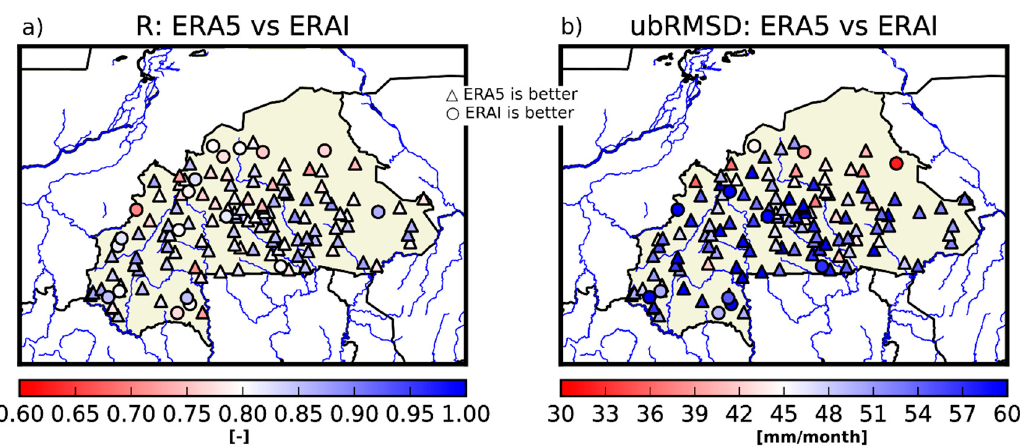
Figure 3. Maps of correlation (R) on precipitation time series ( a ) and ubRMSD (mm/month) on precipitation time series ( b ) between in situ measurements and both ERA-Interim and ERA5. For each station presenting significant R ( p values < 0.05), the simulation that presents the better R values is represented. Triangle symbols indicate when ERA5 presents the best value and circles when it is ERA-Interim.